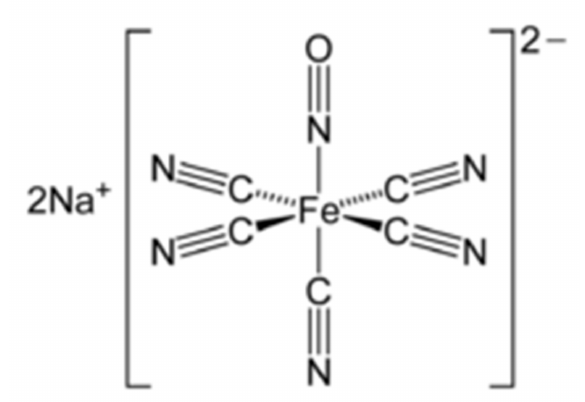
Figure 1. Chemical structure of sodium nitroprusside